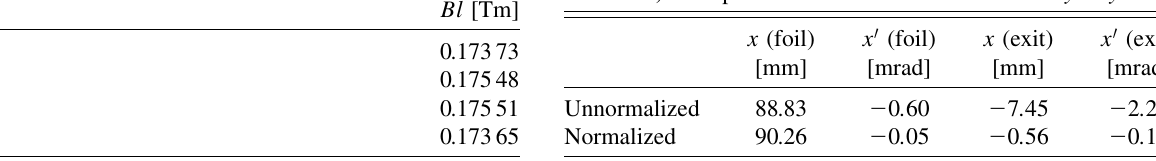
TABLE II. Bl values of the shift-bump magnets at the central